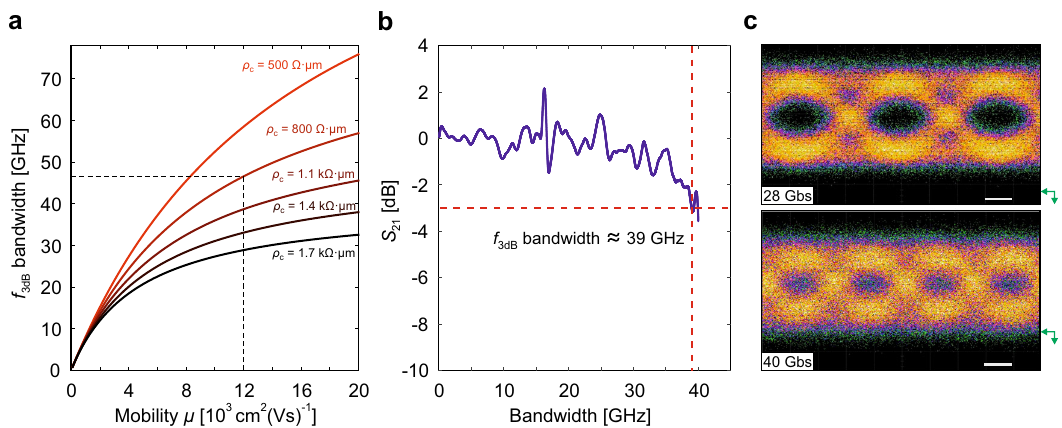
Fig. 2 Dynamic characterization. a f 3dB bandwidth as a function of the charge carrier-dependent mobility ( μ ) and the contact resistivity ( ρ c ) calculated for a device with the same geometry and dielectric combination as the device in Fig. 1 (see Supplementary Note 11). The dashed lines indicate the expected f 3dB ~46 GHz at μ ~12,000 cm 2 V − 1 s − 1 (evaluated at V BT = 10.4 V, refer to panel b ). b Measured electro-optical S 21 frequency response of the EA modulator at V = 10.4 V and V = 200 mV, without de-embedding, i.e., including the contributions of the setup and photodetector (see Supplementary Note 12). c In BT AC all, 2 31 − 1 pseudo-random binary sequence non-return-to-zero eye diagram at 28 and 40 Gbps. The EA modulator is d.c. biased at V BT = 11 V and driven by a V AC = 3.5 V peak-to-peak RF signal. The eye diagram measured at 40 Gbps has a 5.2 dB ER and a 2.28 dB signal-to-noise ratio (SNR). The green arrows indicate the 0 W baseline, and the white scale bar corresponds to 10